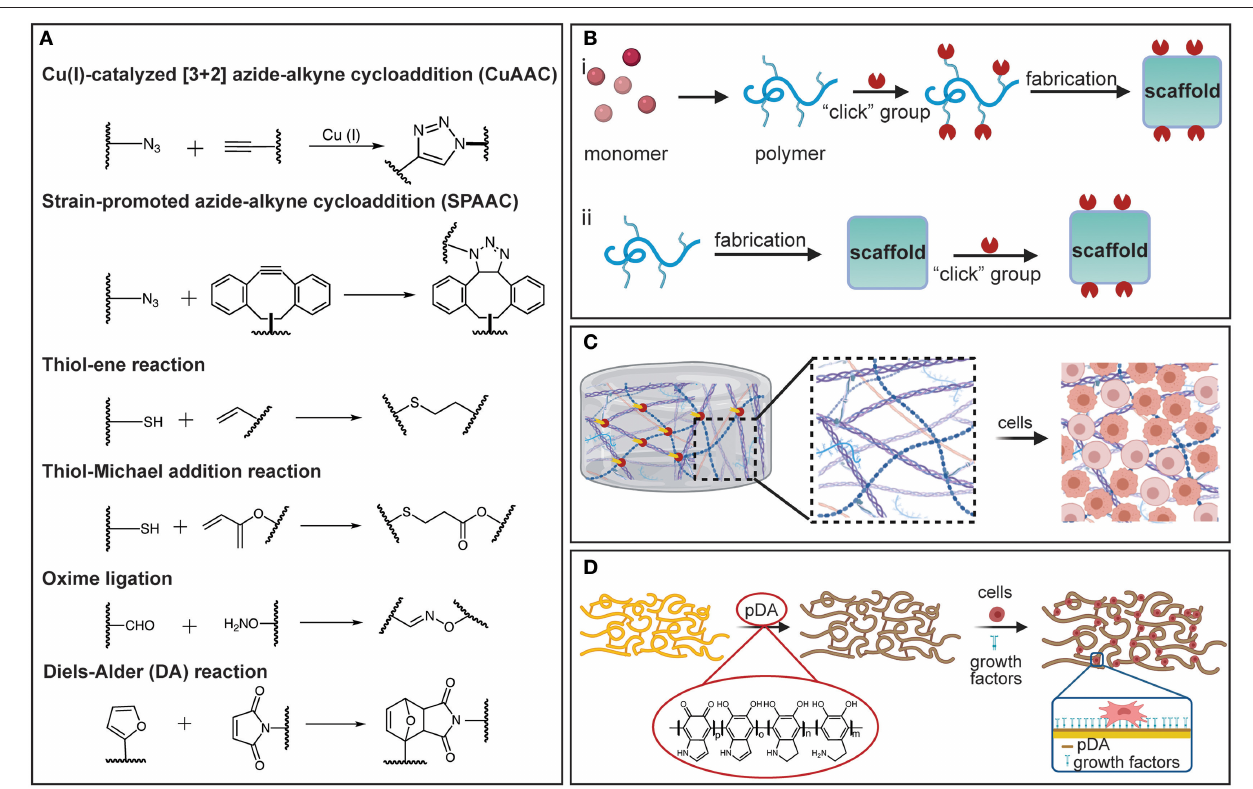
FIGURE 2 | (A) Representation of various click chemistry reactions used in the fabrication of polymeric scaffolds. (B) Fabrication strategies based on click chemistry: (i) pre-click and (ii) post-click. (C) Schematic illustrating a hydrogel crosslinked by click chemistry and functionalized with ECM-based molecules to promote cell attachment and differentiation. (D) Schematic showing a PDA-coated electrospun scaffold decorated with growth factors to promote cell differentiation. [ (B–D) were created with